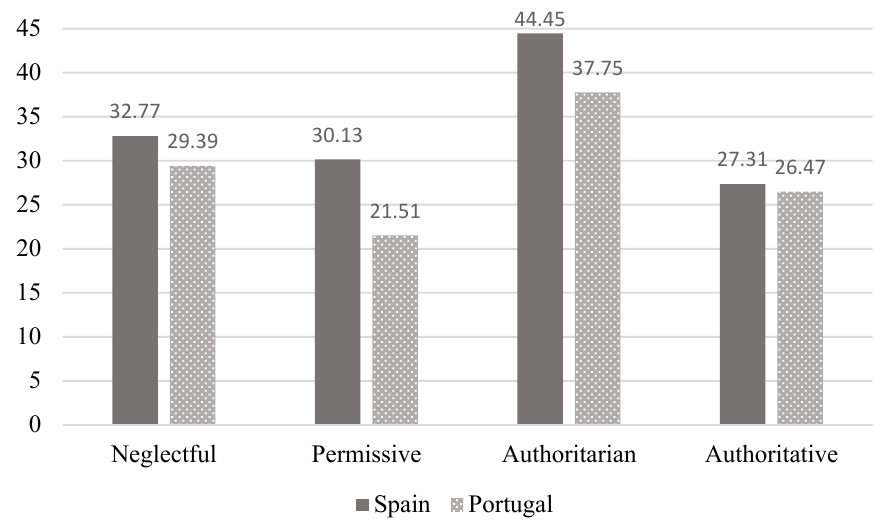
Figure 4. Differences in psychological distress according to parenting styles in Spain and Portugal.